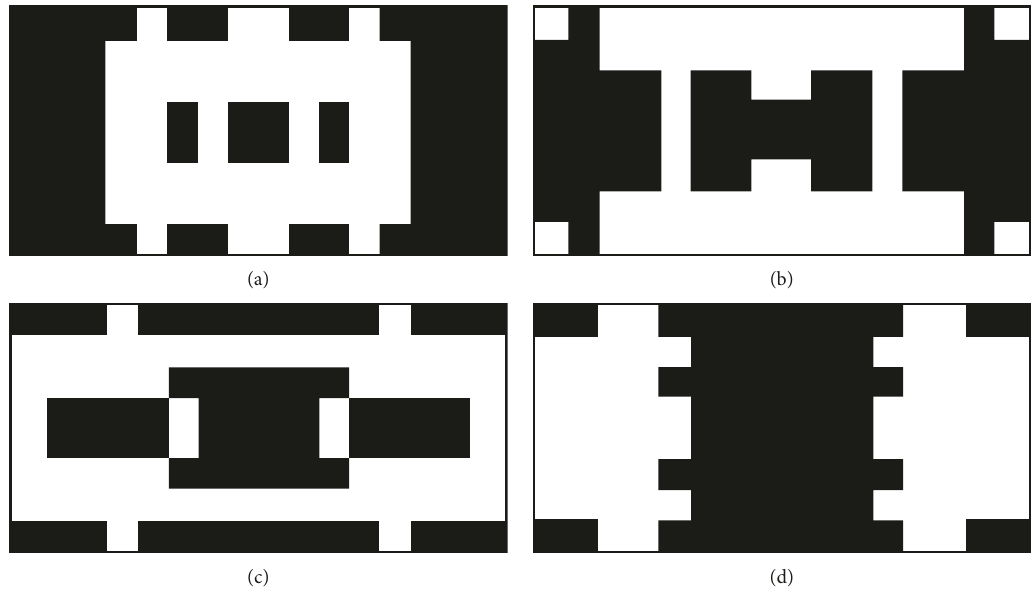
Figure 11: The optimal layouts of CLD treatment. (a) f andthe initialvalues ofthedesign variables0.75. (c) f and the initial values of the design variables 0.75.